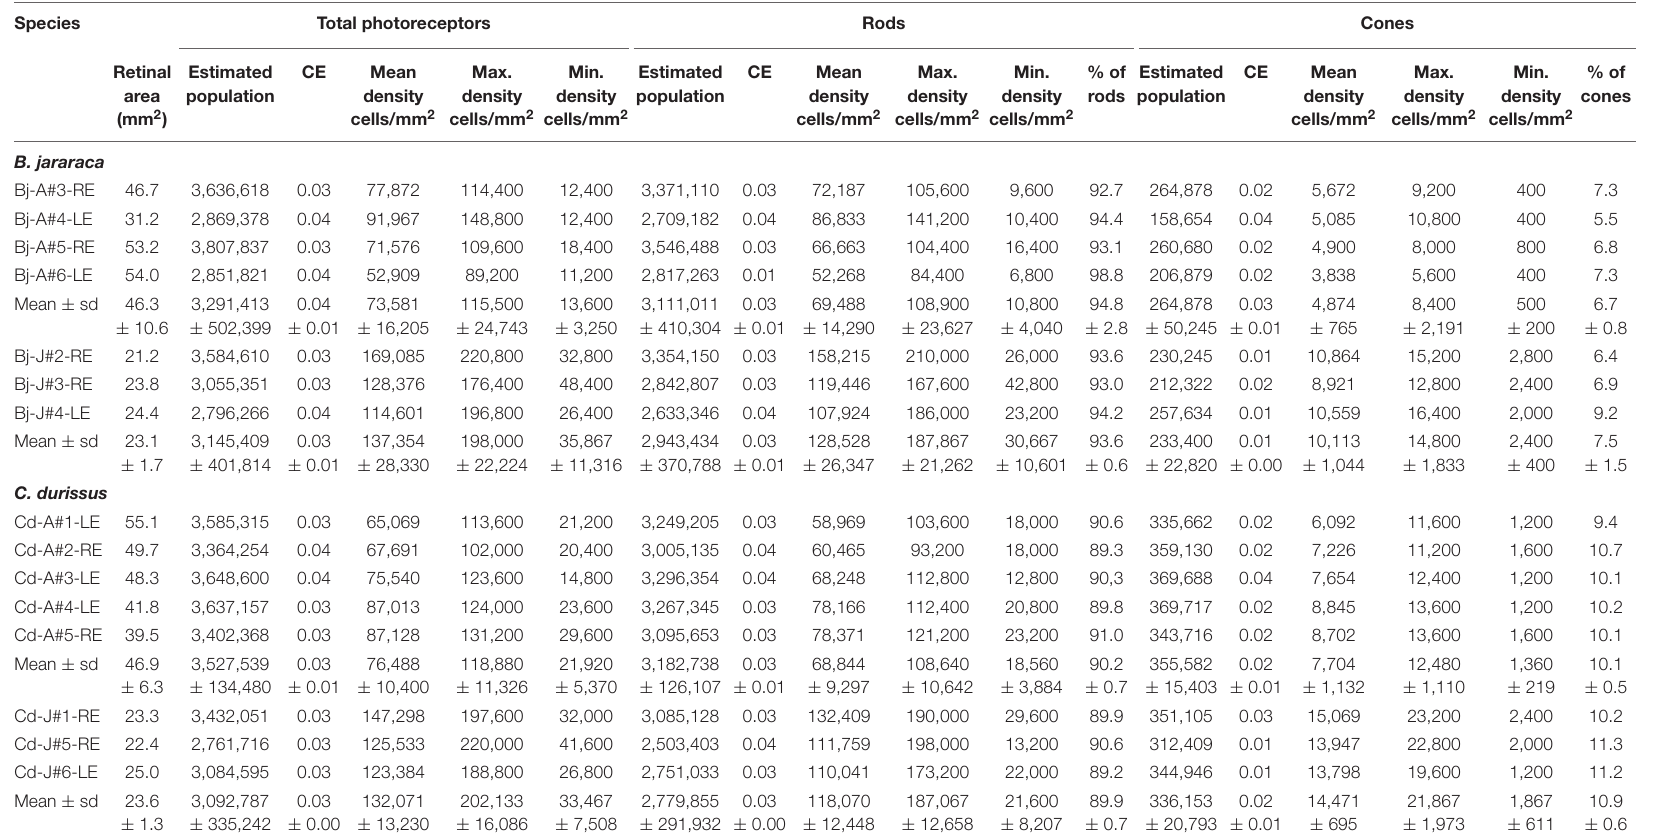
TABLE 2 | Stereological assessment of total photoreceptors, rods and cones in retinas of adults and juveniles of B. jararaca and C. durissus .